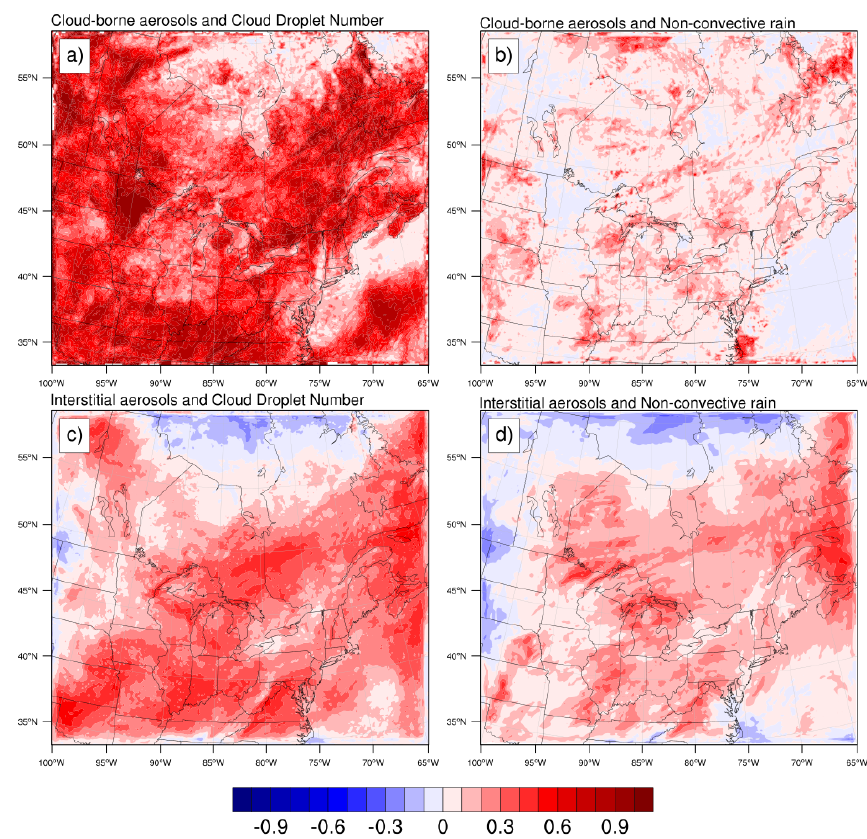
Figure 8. Correlation between simulated WRF/Chem cloud droplet number (left) and non-convective rain (right), with column-integrated cloud-borne (top) and interstitial (bottom) for size range